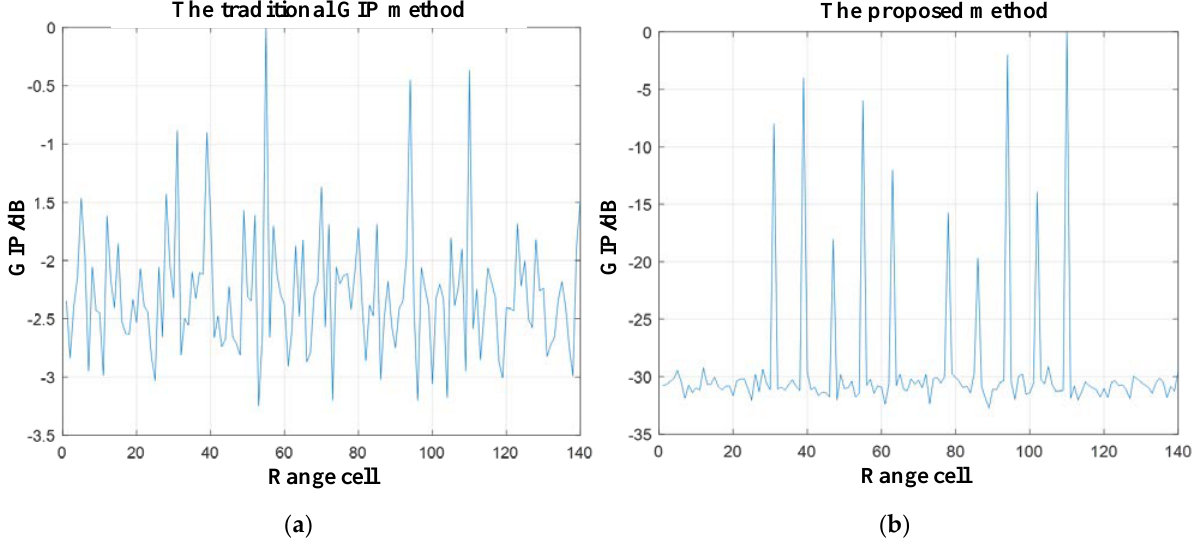
Figure 6. The simulation results of GIP value and output SCNR, they should be listed as: ( a ) GIP value simulation results of the traditional GIP method; ( b ) Simulation results of the GIP value of the proposed method in this paper.